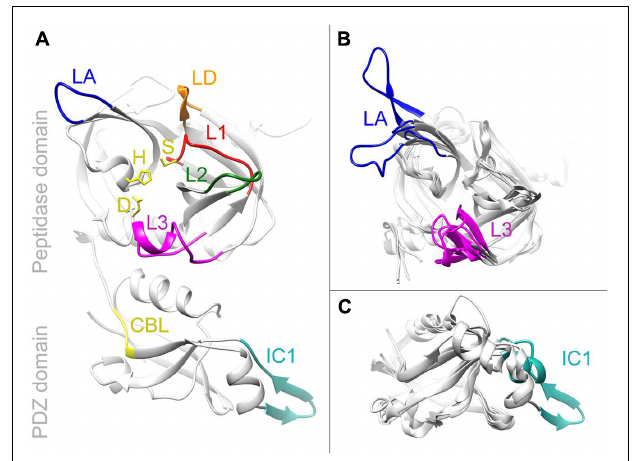
FIGURE 2 | Homology models of HhoB. Models were obtained by Phyre2. (A) SynHhoB modeled after 3STJ, the crystal structure derived of E. coli DegQ. Side chains of the catalytic triad (H151, D181, and S258) are shown in yellow. They are surrounded by loops forming the active site: activation loop LD in orange, loop for the oxyanion hole L1 in red, and the substrate specific loop L2 in green. The regulator loops are LA (blue) and L3 (magenta). Of the PDZ domain the carboxylate binding loop (CBL) is given in yellow and the interaction clamp one (IC1) in cyan. (B,C) Superposition of peptidase domain (B) or PDZ domain (C) using different HhoB models. These models were formed using information of the crystal structures of DegQ, Deg1, Deg2, and Deg8. Color coding is the same as in (A) . Only varying elements were